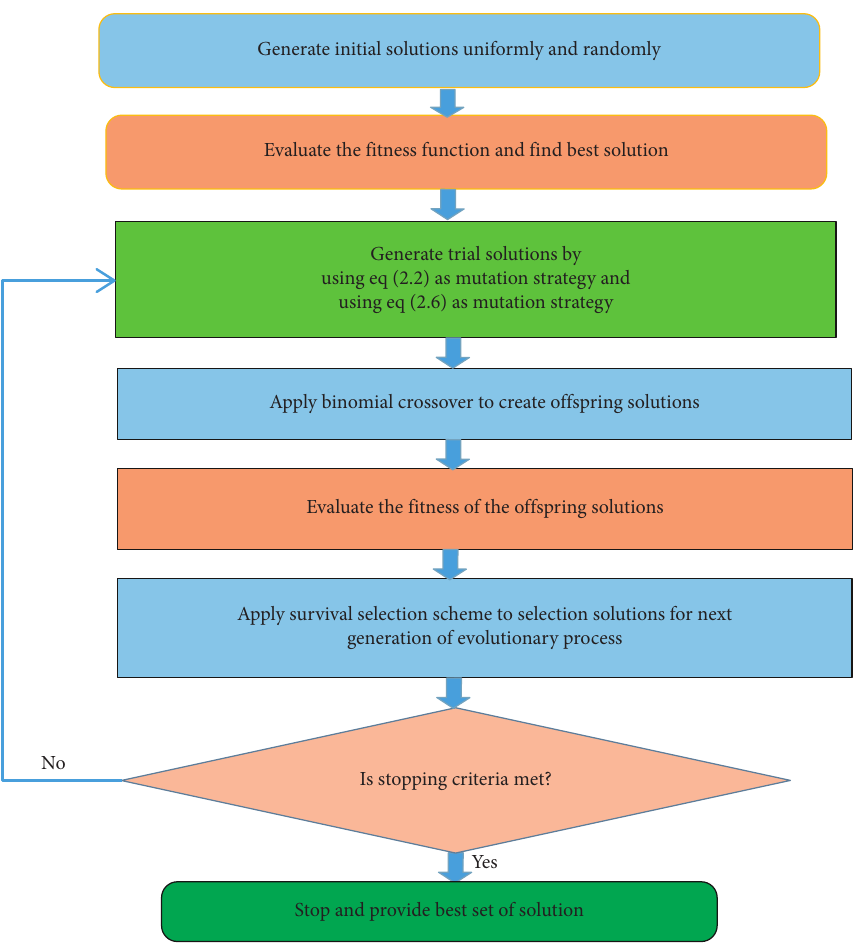
Figure 1: Flowchart of the proposed customized DE (CDE)